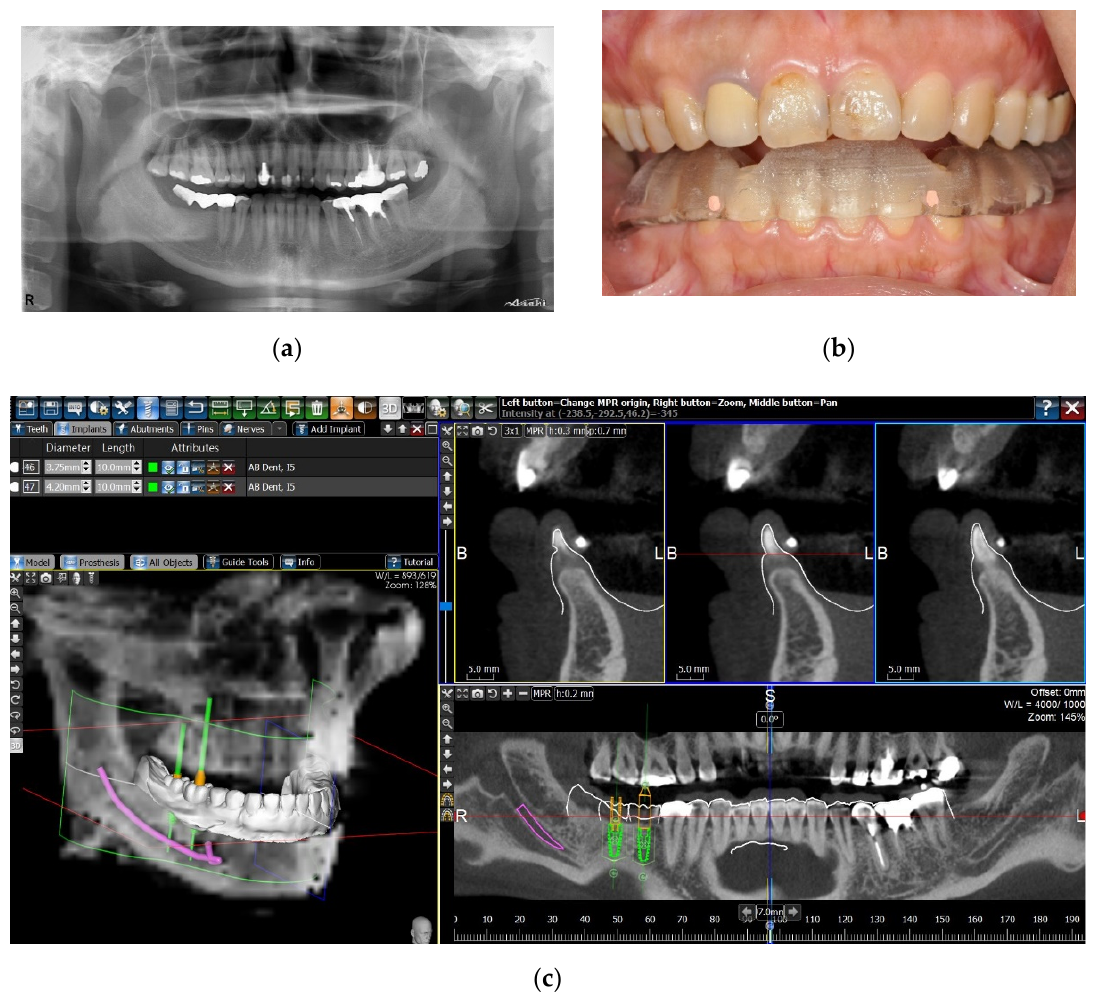
Figure 2. Matching the digital dental cast and the CBCT scan by registration of fiducial markers. ( a ) A patient with missing right mandibular first and second molars. Because of the streaking artifacts from the radiopaque crowns of bilateral posterior area on the CBCT scan, a direct superimposition with the digital dental cast was challenging. ( b ) On the basis of the digital dental cast, an SLA radiographic template with gutta percha fiducial markers was fabricated. The patient took a CBCT scan with the radiographic template in the mouth. ( c ) The image of the fiducial markers could be identified on both the digital dental cast and the CBCT scan, and the two digital images could be superimposed by matching the fiducial markers.